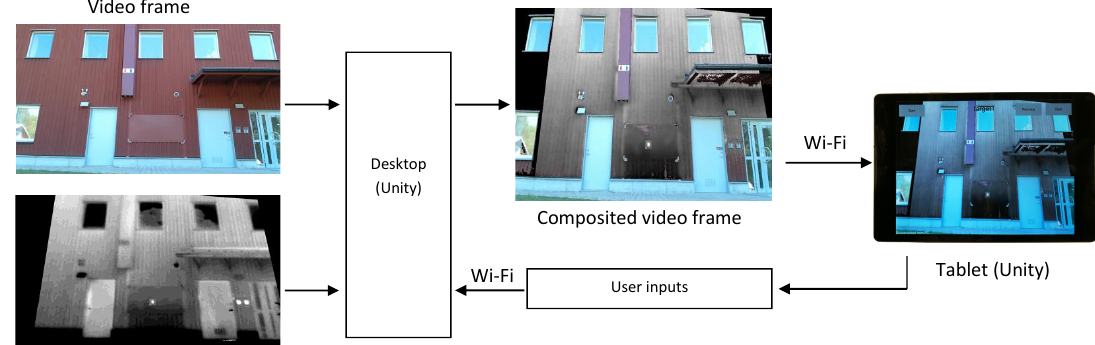
Figure 5. Overview of the system